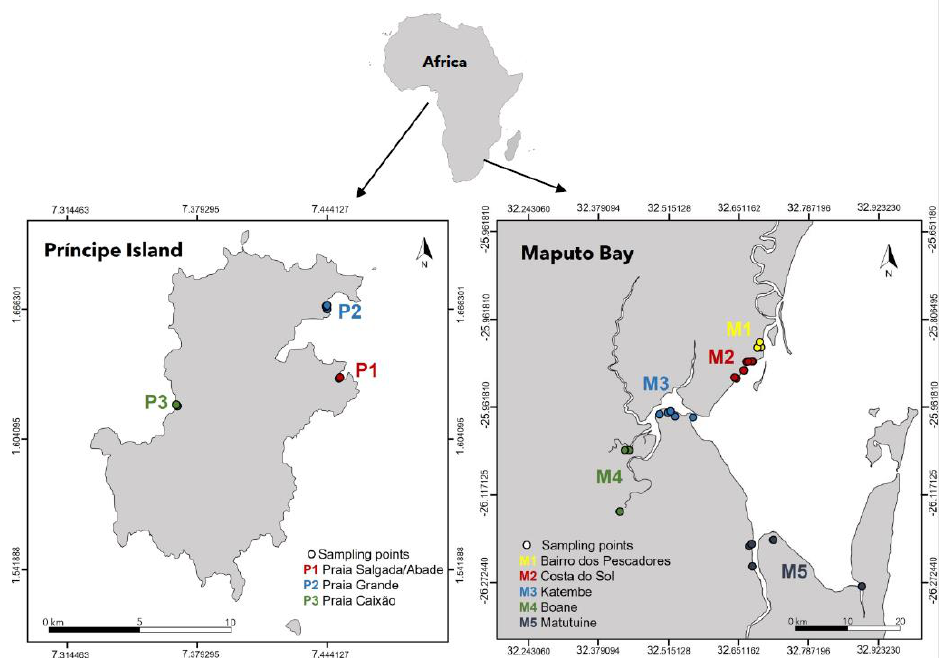
Figure 1. Location of sampling areas in Maputo Bay (eastern Africa) and Príncipe Island (western